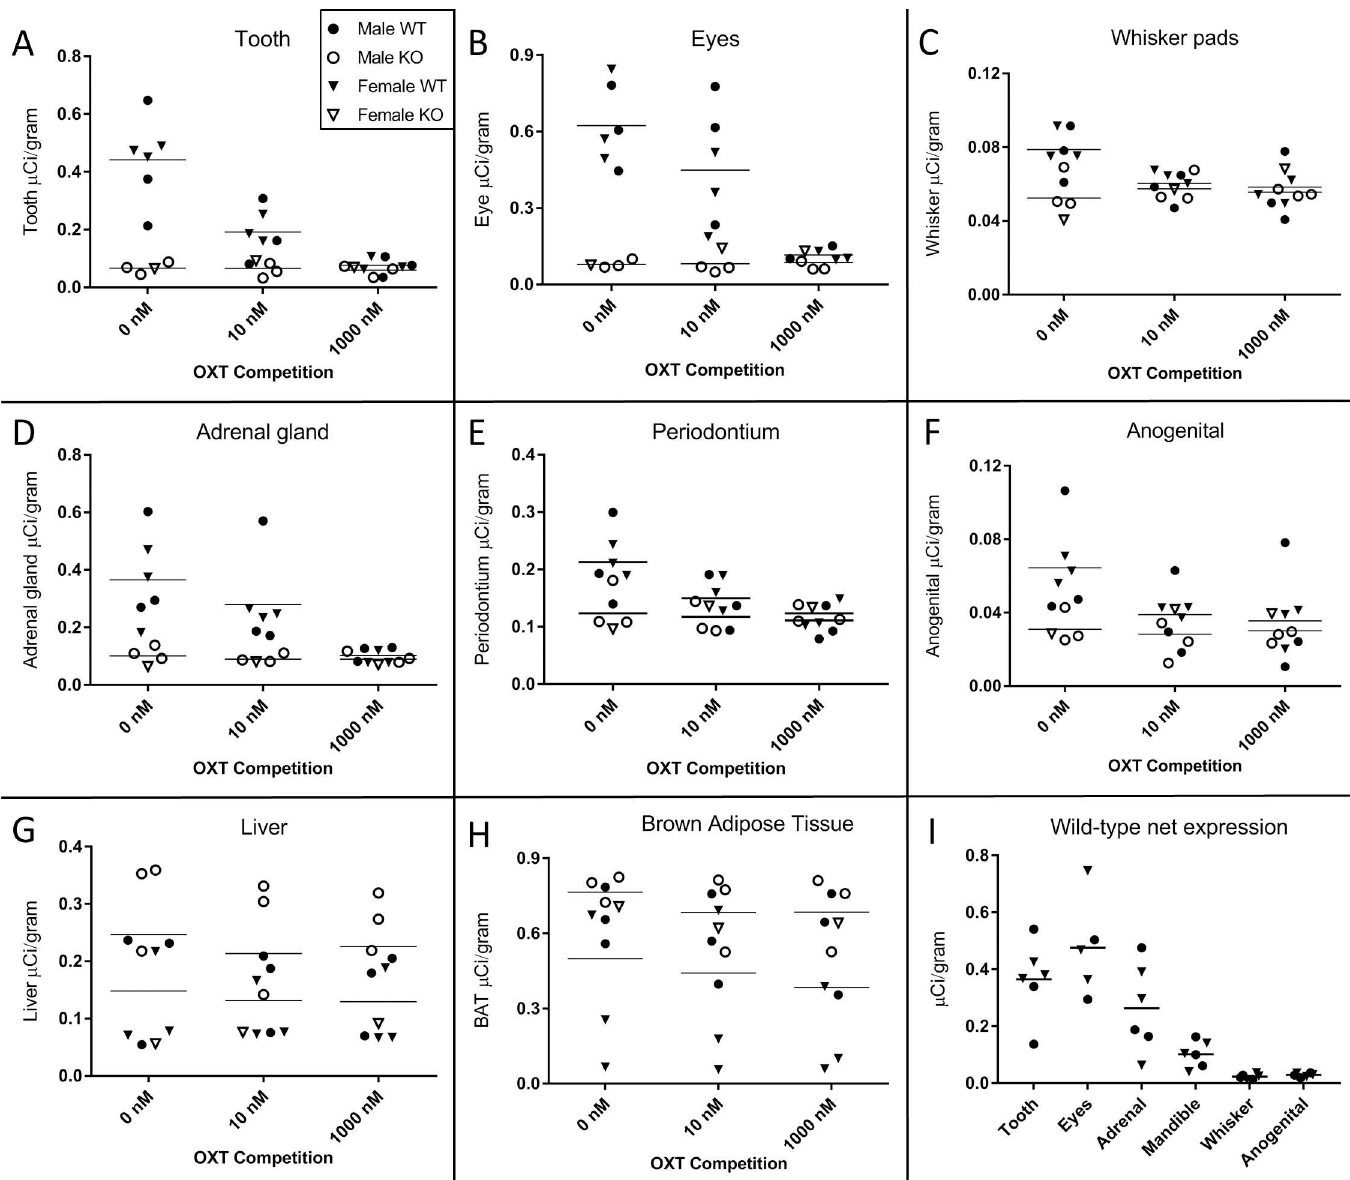
Fig 8. Quantification of receptor autoradiography for OXTR in peripheral tissue of wild-type and OXTR knockout mice. Differencesbetweenwild- type (WT) and knockout (KO) genotypesare evident in the 0 nM OXT competitioncondition, with displacement of bindingin the WT as the competition increasesacross 10 nM and 1000 nM OXT. The y-axis of each graph has beenfit to the scale of the data. (A) Primordialtooth; (B) Eyes; (C) Whisker pads; (D) Adrenalgland; (E) Periodontium; (F) Anogenital;(G) Liver; (H) Scapular brown adiposetissue. The net OXTR bindingvalues (net = density of 0 nM- 1000 nM) for all regions in wild-typemice with specific OXTR ligandbindingare comparedagainsta common y-axis on the final panel (I). Group means and individual subject data are plotted (WT (filled symbols), OXTR KO (open symbols), males (circles), females